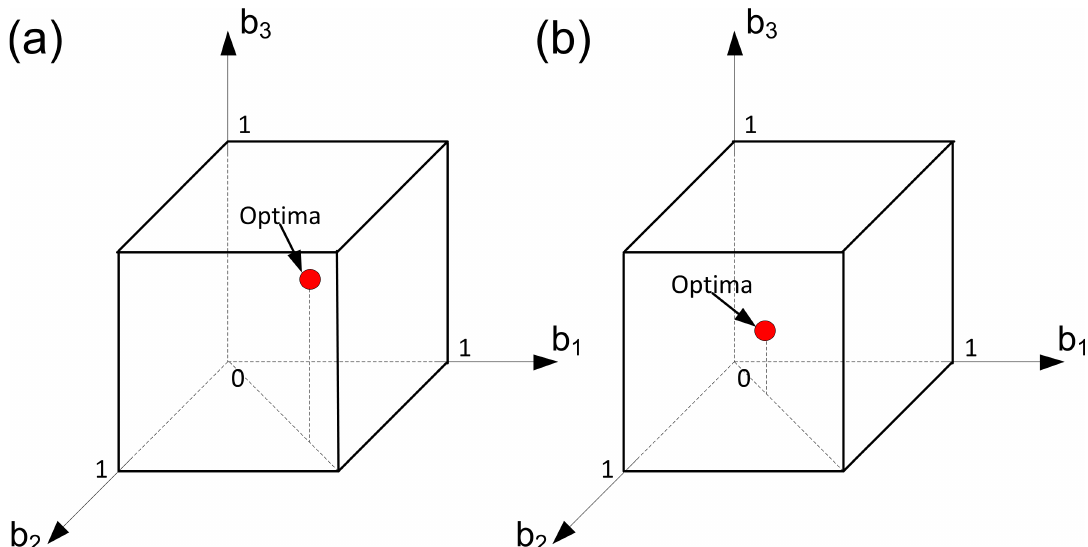
Fig 5. Evolution of germ and soma in colonies with identical cells: A concave trade-off, a resource constraint and different ‘importances’ of viability and fecundity (Case 1). Here we assume that we have three groups of cells within the colony such that all cells from each group have the same level of fecundity and the same level of viability (i.e., we have three ‘aggregate’ cells in the colony). Optimal strategies of the colony are colored in red. In both panels, the colonies have a unique optimal strategy and the specialization does not occur. The contribution of the colony to the fitness components depends on the relative importance of fecundity to viability. In both panels, α = 1, φ = 1- b 2 , C = 8, k 1 = 2 and k 2 = 1. In panel (a), β = 0.5. In panel (b), β = 2.